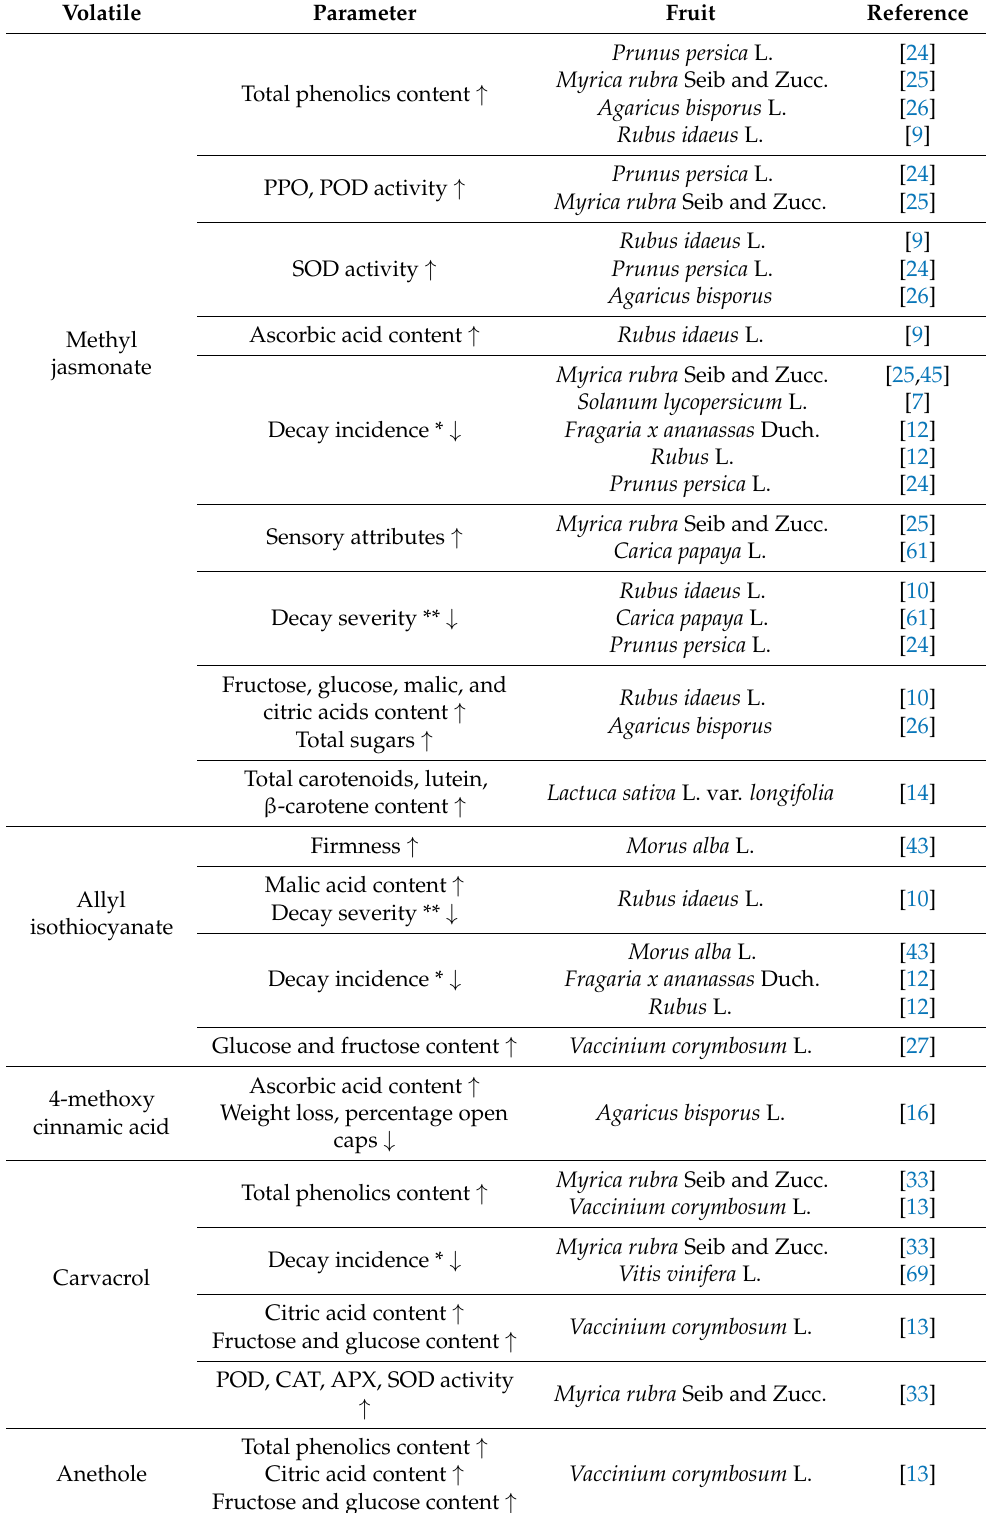
Table 1. Presentation of volatiles that enhanced quality of analyzed fruits in